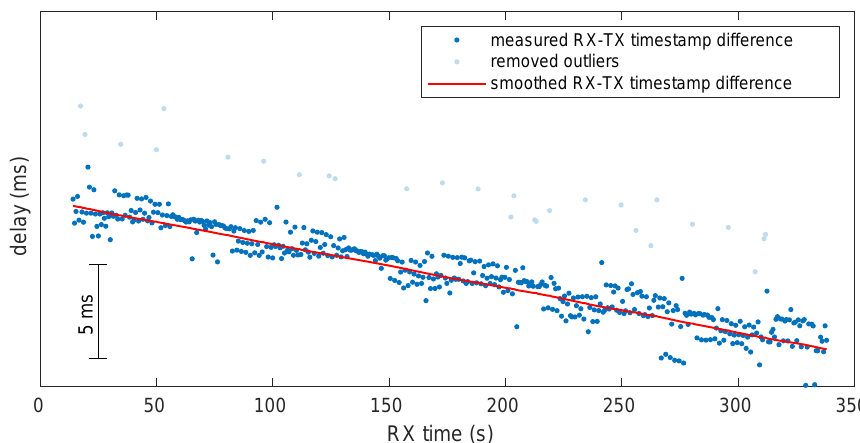
Figure 7. Example of measured delay between TX timestamp and RX timestamp. The graph is plotted with an arbitrary vertical offset because TX and RX clocks do not have a common starting